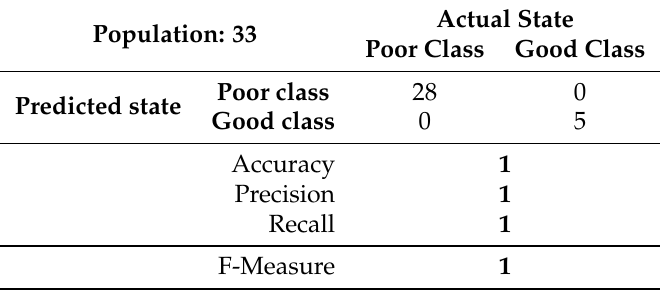
Table 14. Reliability analysis of identification based on combination of software metrics.